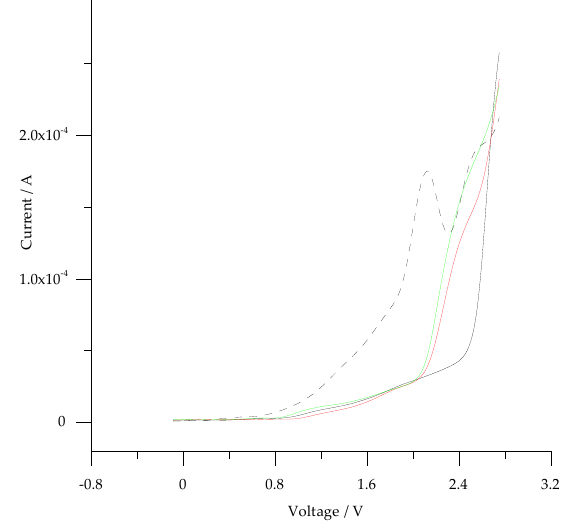
Figure 3. Anodic scan of HS-derivatives separately investigated in AN/0.05 M TBAP at the Pt-quartz crystal WE, Ag/Ag + non-aqueous RE, Pt-wire AE, scan rate 50 mVs −1 . Cbz-HS 1 mM (dashed line); Acetyl-HS 1 mM (solid line red) and Acetyl-HS 2 mM (solid line green); solid line black: background AN/0.05 M TBAP.